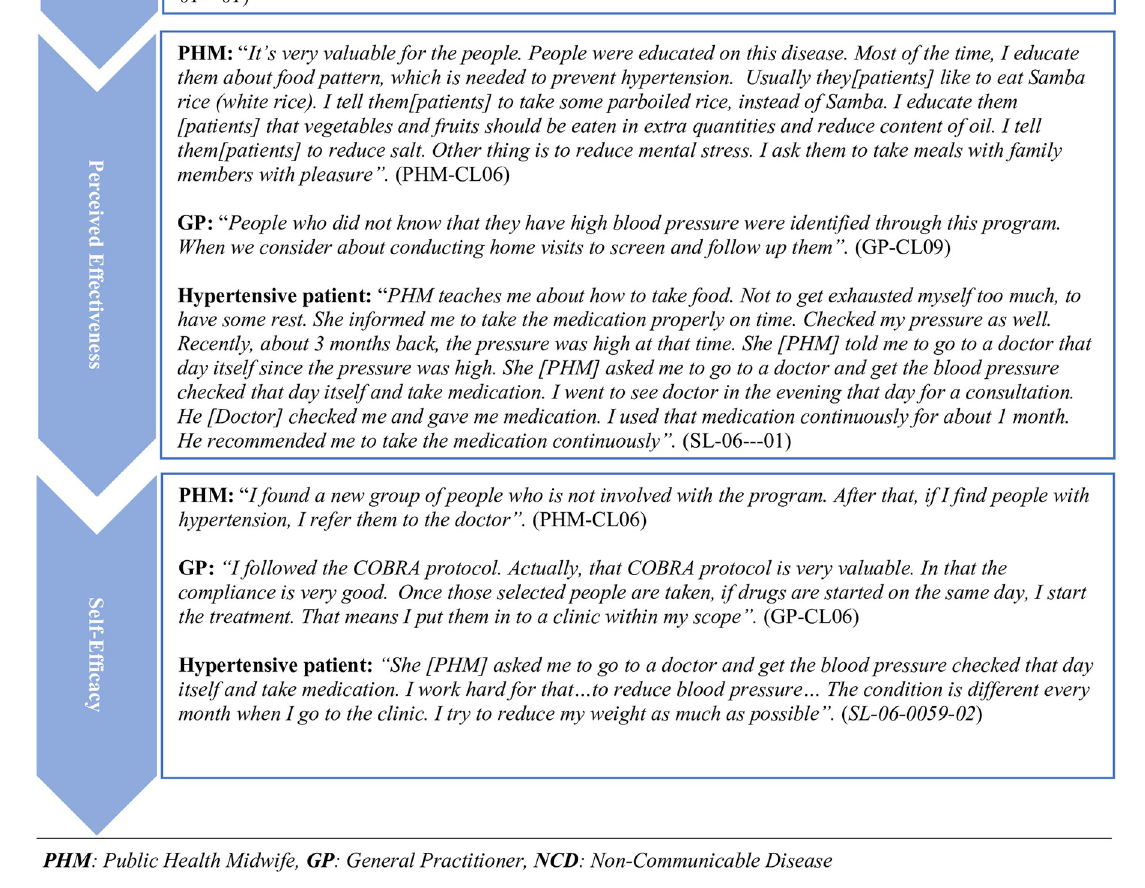
Fig 3. Illustrative quotes from Sri Lanka participants. “ Whenever I sought pharmacy shops , they [pharmacist] provided medicine based on assump- tion and always suggested to buy medicine . If I needed 10 mg , he gave me 50 mg . But your man [CHW] measured two times my blood pressure every time . He didn’t measure